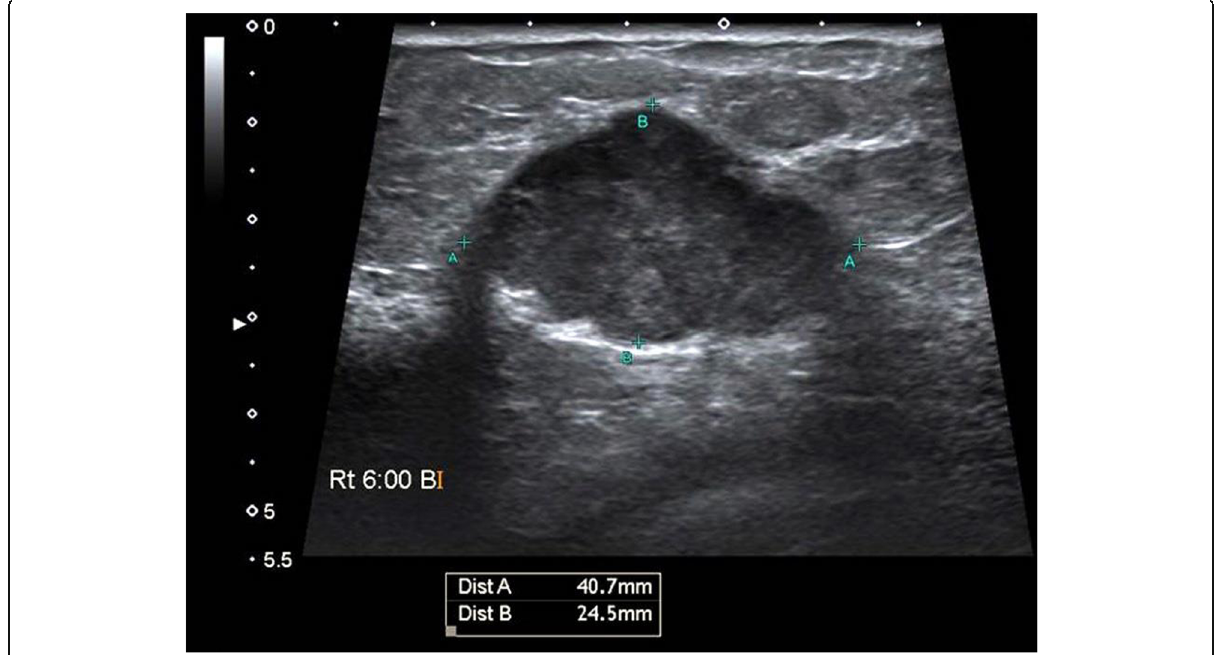
Fig. 5 B mode US shows oval-shaped hypoechoic solid mass with lobulated margin, parallel orientation, and posterior enhancement, and it measures about 40 × 24 mm assessed as BIRADS 4b. Pathology: true cut biopsy revealed DCIS (grade 2). Biological markers: ER positive, PR positive, HER/neu-2 negative, and Ki67